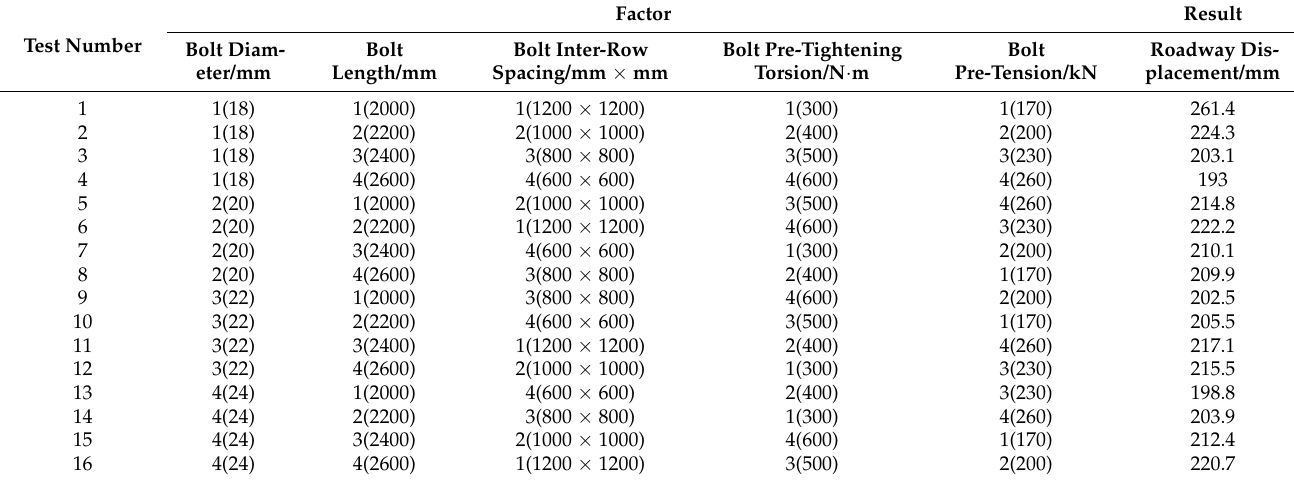
Table 7. Orthogonal numerical simulation test scheme.